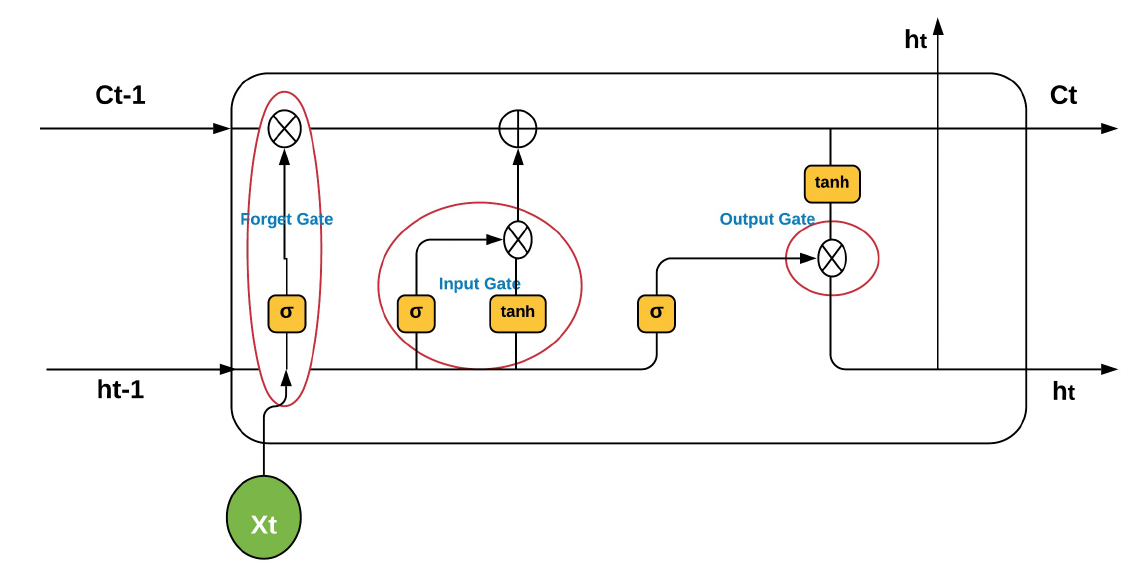
Figure 1: LSTM Cell